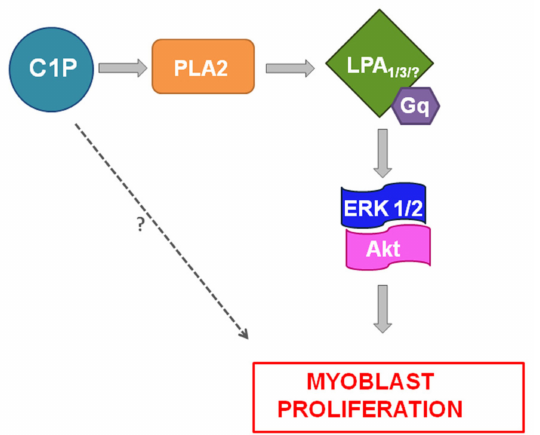
Figure 8. C1P stimulates C2C12 myoblast proliferation. The dashed arrow and question marks indicate unexplored pathways that could be partially implicated in C1P mitogenic action in